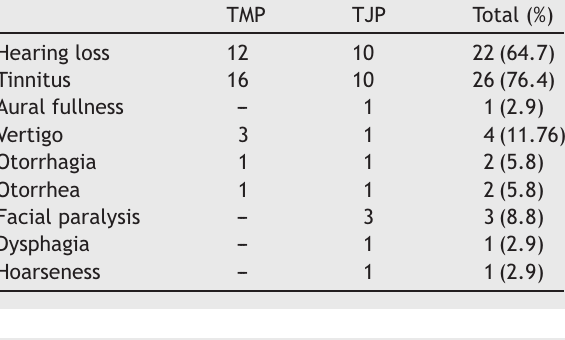
Presenting symptoms for temporal bone